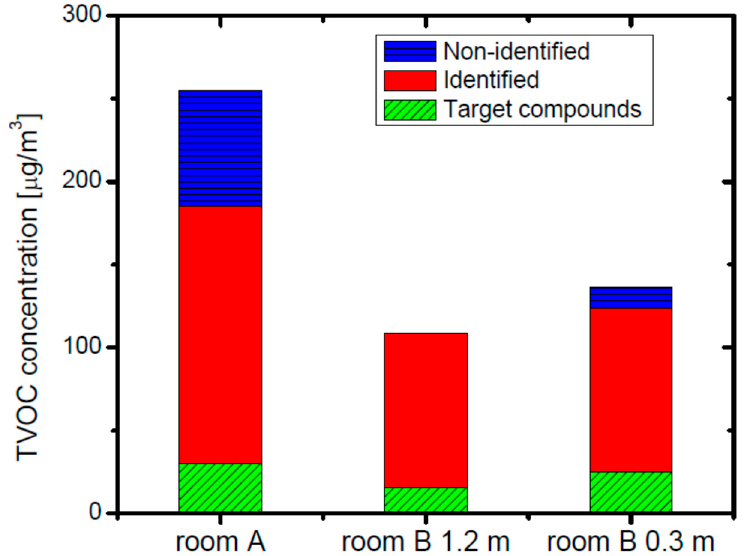
Figure 3. TVOC concentrations and compositions in rooms A and B (at 1.2 m and 0.3 m above the floor) 3 months after the building was completed.